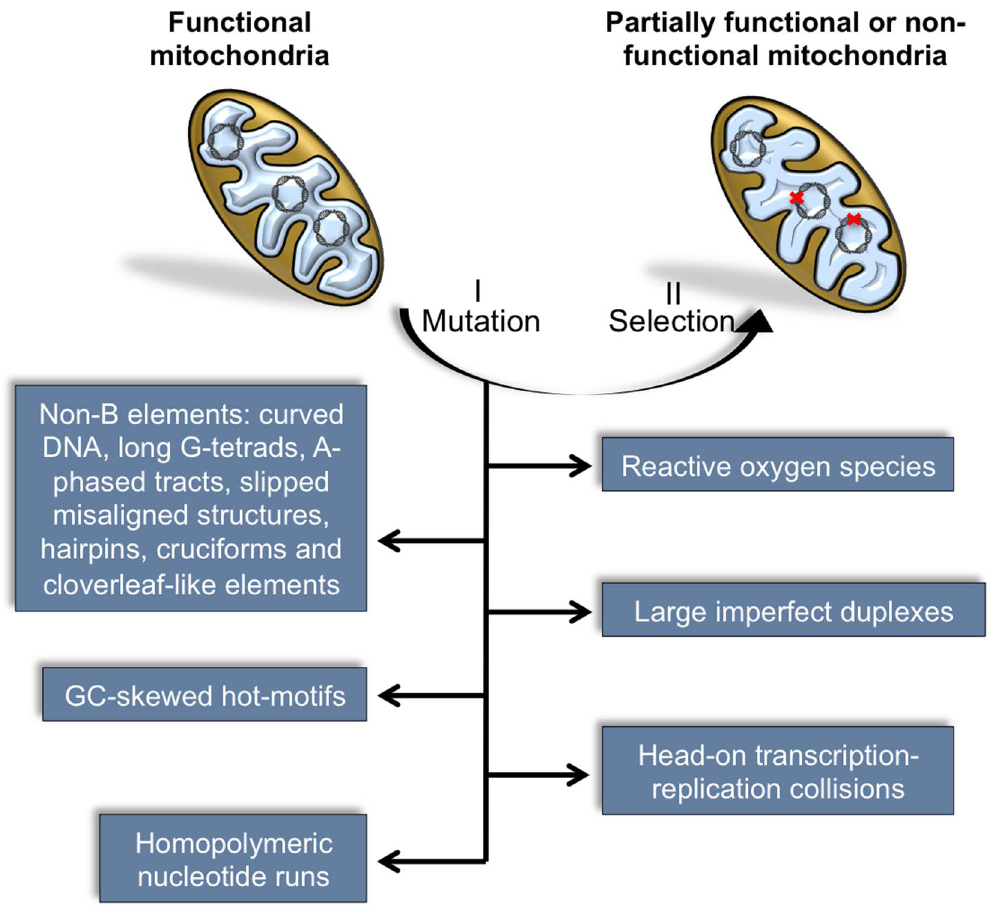
Figure 6. Diagram illustrating the sequence of events (I, II) capable of driving functional mitochondria to shift to a partially functional or non-functional state. The mutational events (I) may arise as a consequence of unusual DNA conformations, fragile motifs, exogenous factors, among others. These mutations will co-exist with the wild-type mtDNA in a heteroplasmic state, or eventually be selected (II) until a homoplasmic state is